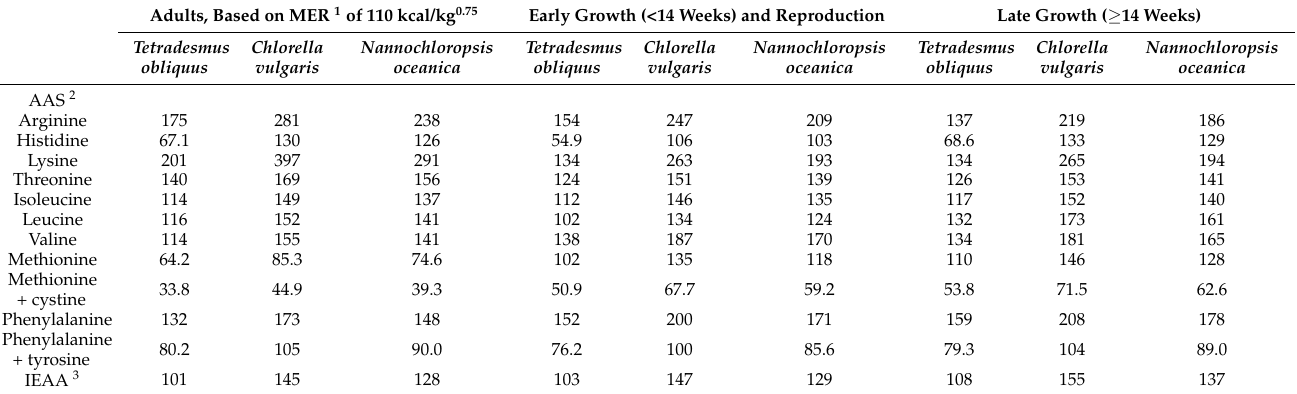
Table 3. Amino acid scores (AAS) and index of essential amino acids (IEAA) of the studied microal- gae